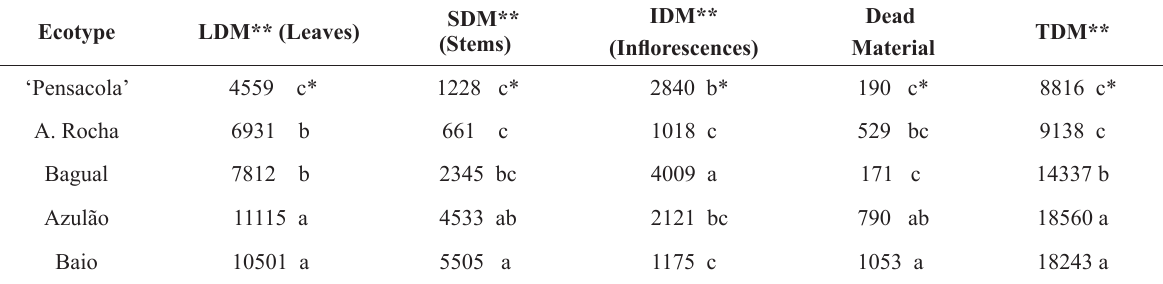
Dry matter production of the components of the aerial part and the total, in kg/ha, of the ecotypes Paspalum spp. and cv. ‘Pensacola’, in the first year of evaluation, Eldorado do Sul.